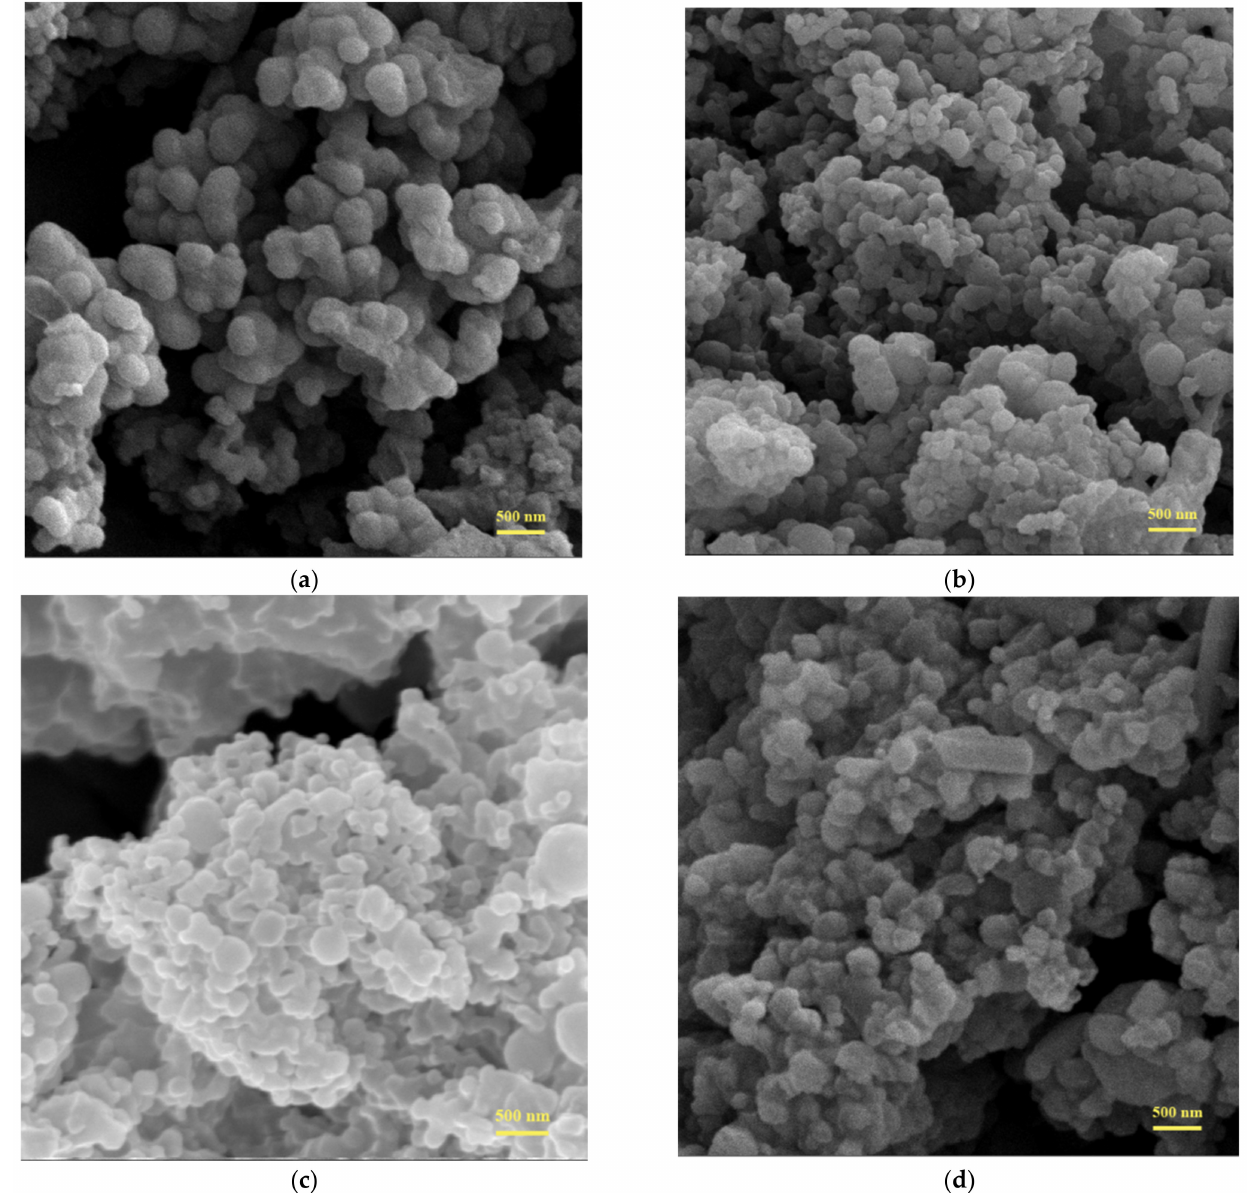
Figure 6. SEM of the microcapsules prepared by different core/shell ratio: ( a ) 1:1 ( b ) 2:1 ( c ) 3:1 ( d )